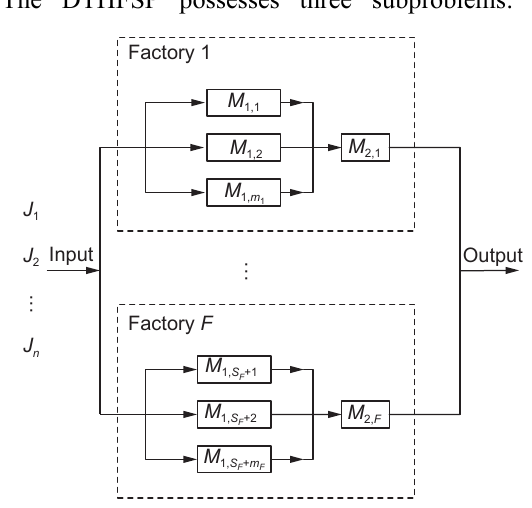
Fig. 1 Layout of the distributed two-stage hybrid flow shop scheduling problem